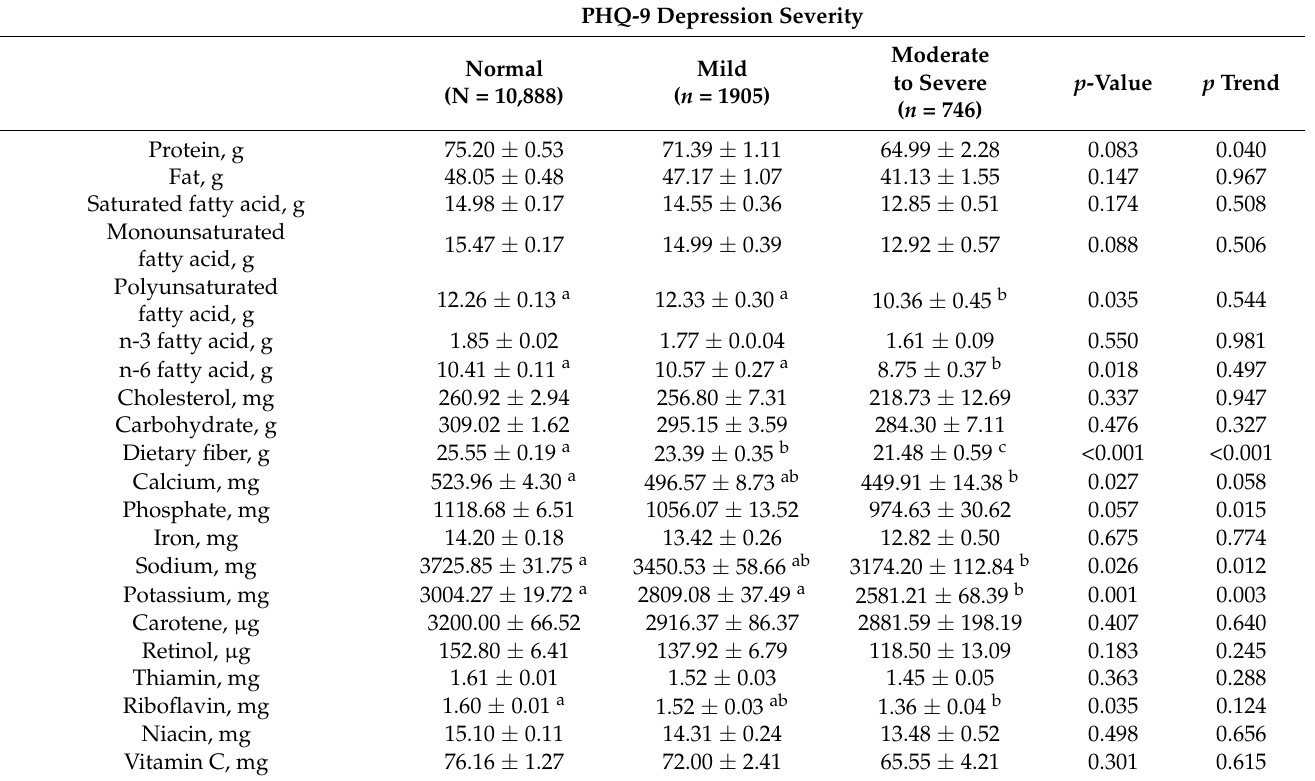
Table 3. Nutrient intakes of subjects according to depression